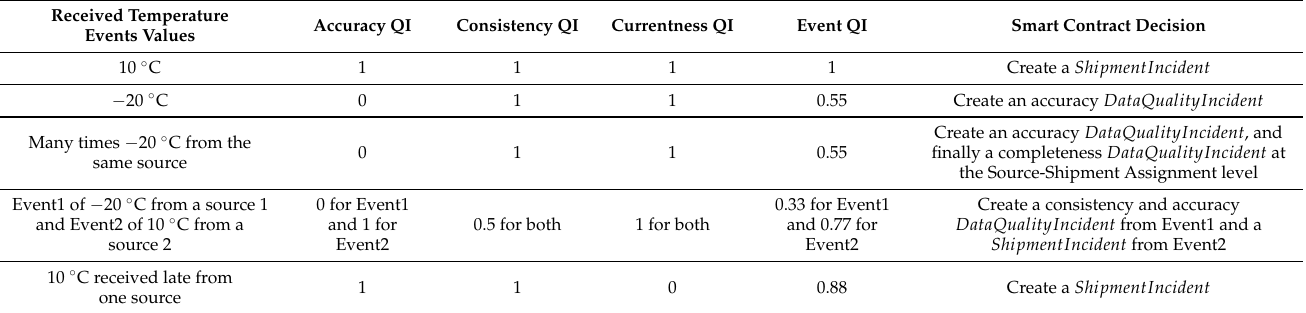
Table 2. Smart contract decisions